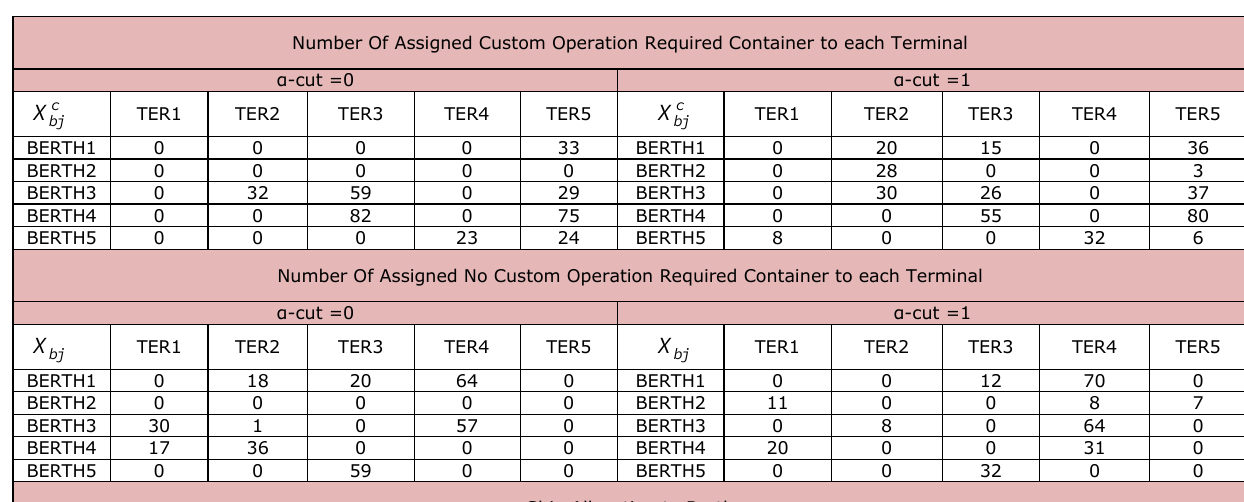
Table 6. “Solution Structure for Optimistic Programming”.